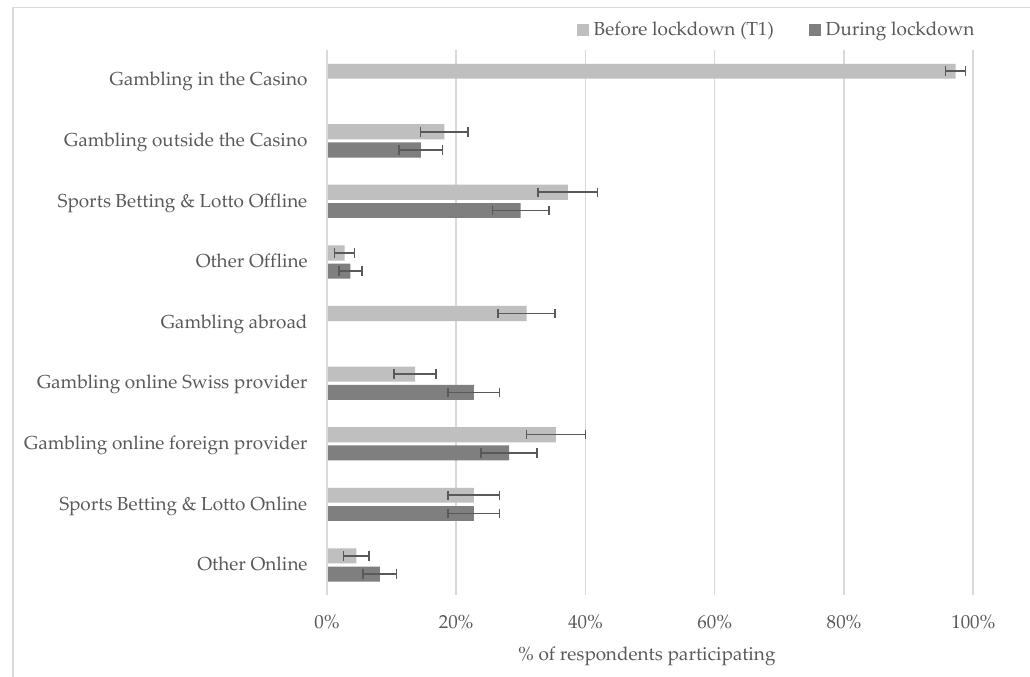
Figure 1. Relative Participation in Different Games Before and During Lockdown ( n = 110). Note: The bars indicate the proportion of respondents who participated in each type of gambling. The error bars represent the mean +/− the standard error of the mean.